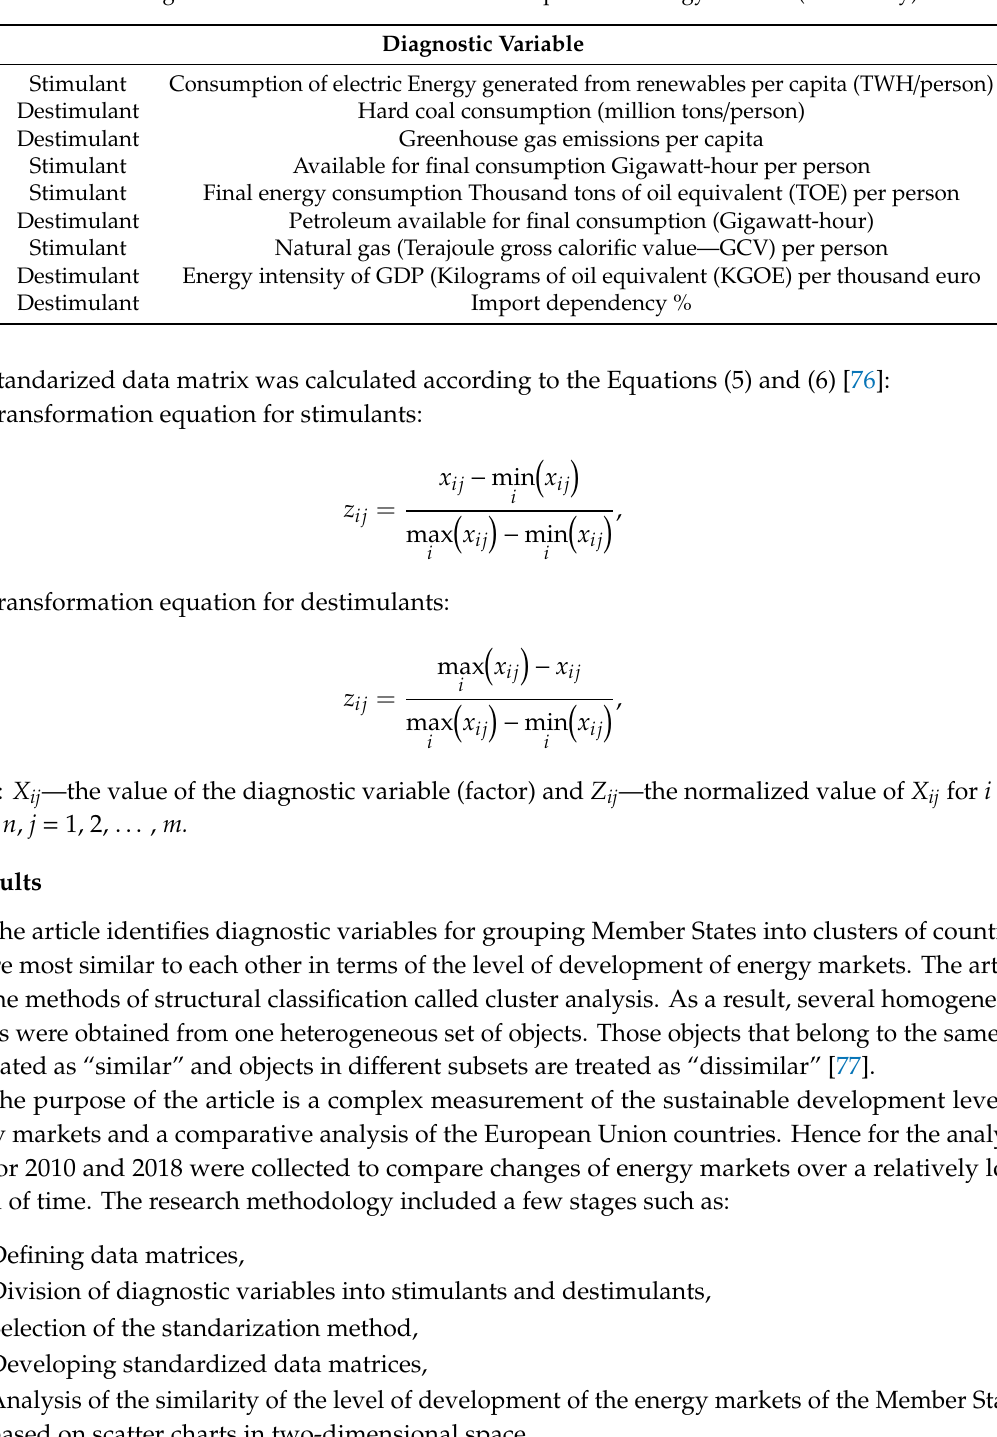
Table 1. Diagnostic variables of sustainable development of energy markets (own